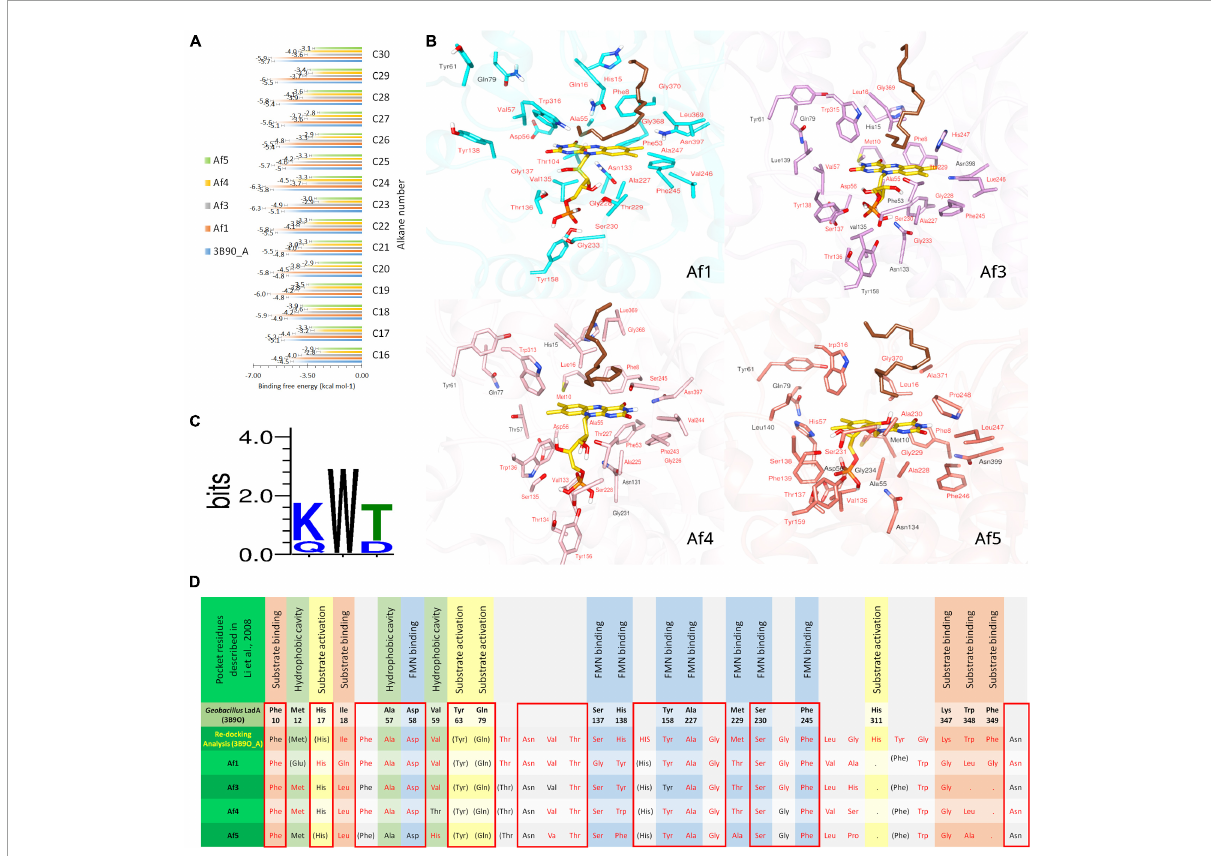
FIGURE4 Docking simulations of A. flavus LadA α homologs with FMNopt and hexadecane. (A) Binding free energy of n -alkanes (C 16 –C 30 ) into 3B9O A: FMNopt, Af1 : FMNopt, Af3 : FMNopt, Af4 : FMNopt, and Af5 : FMNopt complexes. (B) Active pocket residues of each of the four hexadecane (dark brown) (C 16 )-bound A. flavus LadA α homologs: FMN (gold) complexes. (C) Conservation of substrate-binding residues, (K/Q) W (T/D) in A. flavus LadA α homologs Af1 , Af3 , Af4 , and Af5 . (D) Comparison of active pocket residues of A. flavus LadA α homologs with FMNopt and hexadecane: Af1 , Af3 , Af4 , and Af5 and re-docking analysis of 3B9O_A visualized by BIOVIA Discovery Studio Visualizer and UCSF Chimera; residues within 5 Å from the bound ligands inside the active pocket are labeled in red lettering, while others are in black. Active pocket residues of G. thermodentrificans LadA (Li et al., 2008) that were conserved but observed outside the active pocket in the A . flavus homologs are depicted in brackets (FMN binding , Substrate binding , Hydrophobic cavity , Substrate activation , other , Conserved (100%)